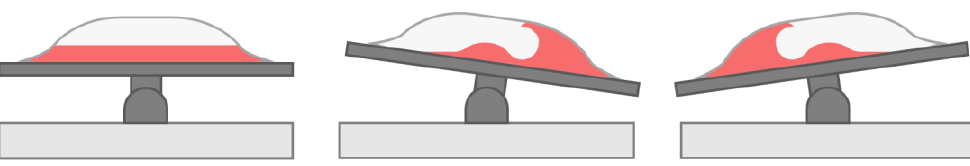
Figure 7. Schematics of a rocking motion bioreactor. The back-and-forth rocking motion of the base will lead to the formation of waves inside the vessel, allowing for efficient mixing.